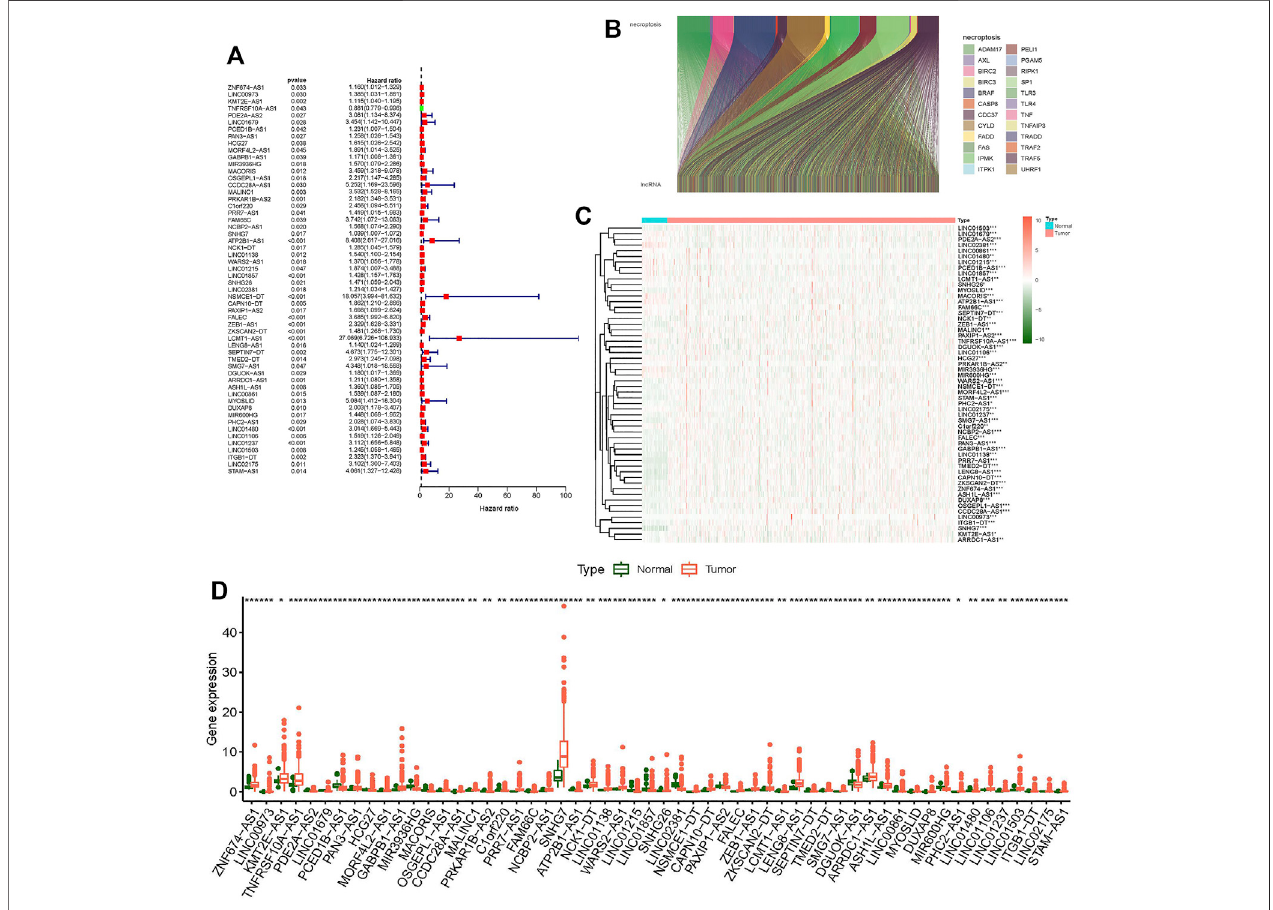
FIGURE 1 | Differentially expressed genes of necroptosis-related lncRNAs in colon tumor and normal tissues. (A) Forest plot shows prognostic-related genes of necroptosis-relatedlncRNAs. (B) Sankeyrelationaldiagramfornecroptosisgenesandnecroptosis-relatedlncRNAs. (C) Heatmapshowsdifferentiallyexpressedgenes of necroptosis-related lncRNAs. (D) Boxplot shows differentially expressed genes of necroptosis-related lncRNAs. * p < 0.05, ** p < 0.01, *** p < 0.001.